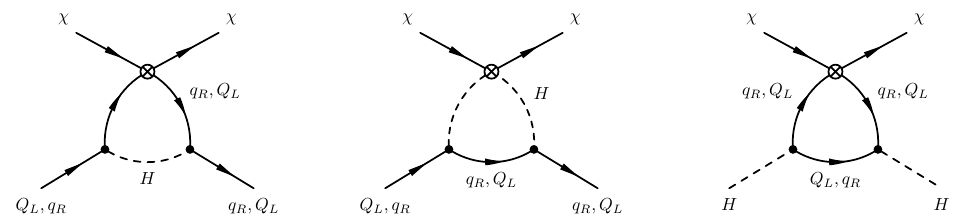
Figure 10 . Mixing of the quark operators proportional to the quark yukawa coupling due to the insertion of DM-quark and DM-Higgs operators. We consider only the top, bottom, charm Yukawas here and so q t; b; c . The same diagrams with Q L 2 f g DM-Higgs operators. These diagrams only contribute to o(cid:11)-diagonal